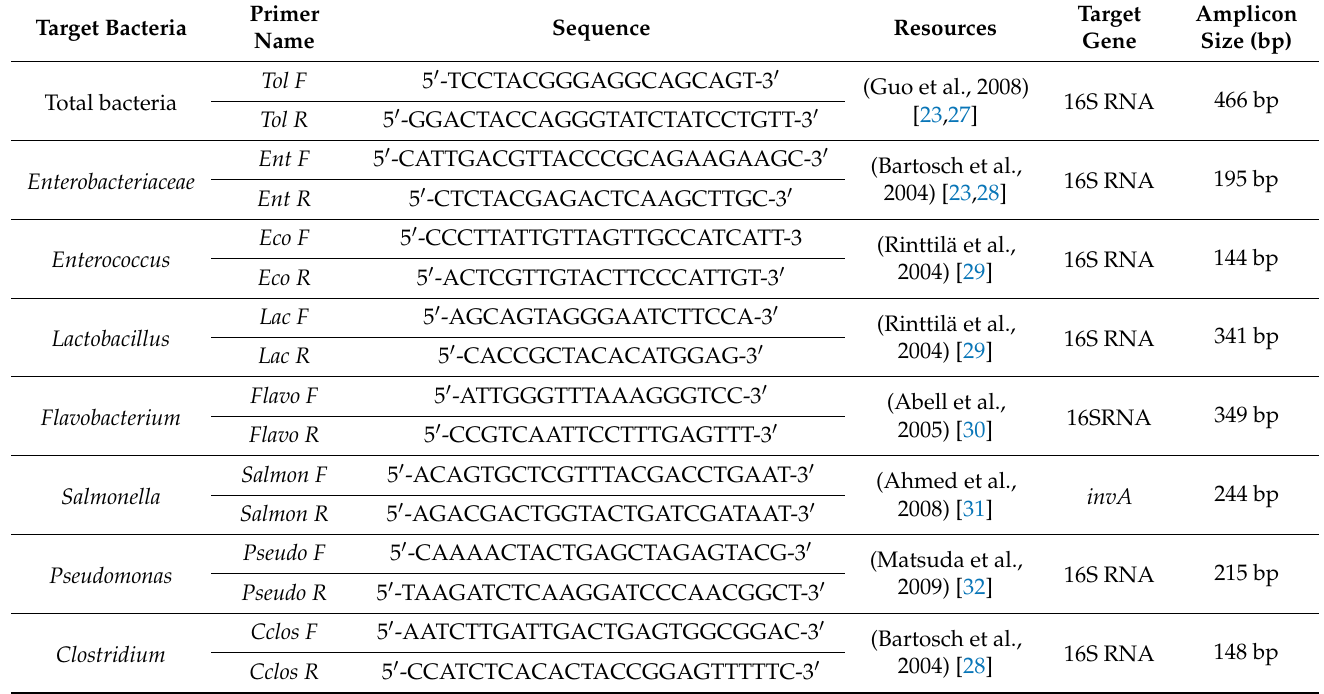
Table 3. The primers used for different bacteria